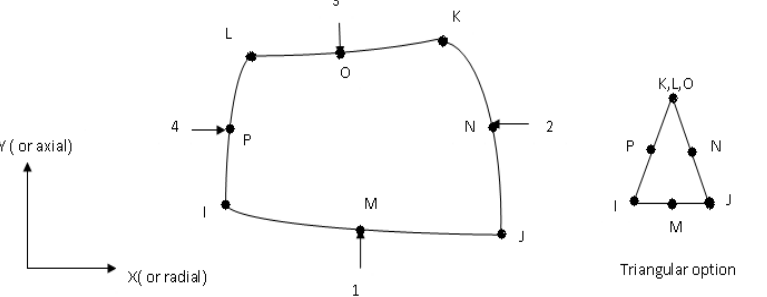
Figure 3: PLANE 82 elements with